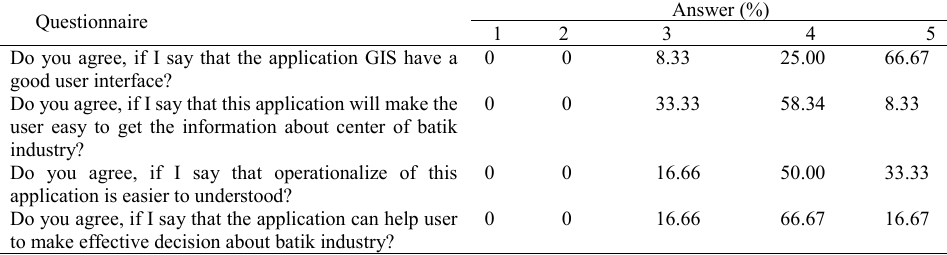
Table data of batik based on its category, scale of enterprise, and the location of enterprise table data of supplier